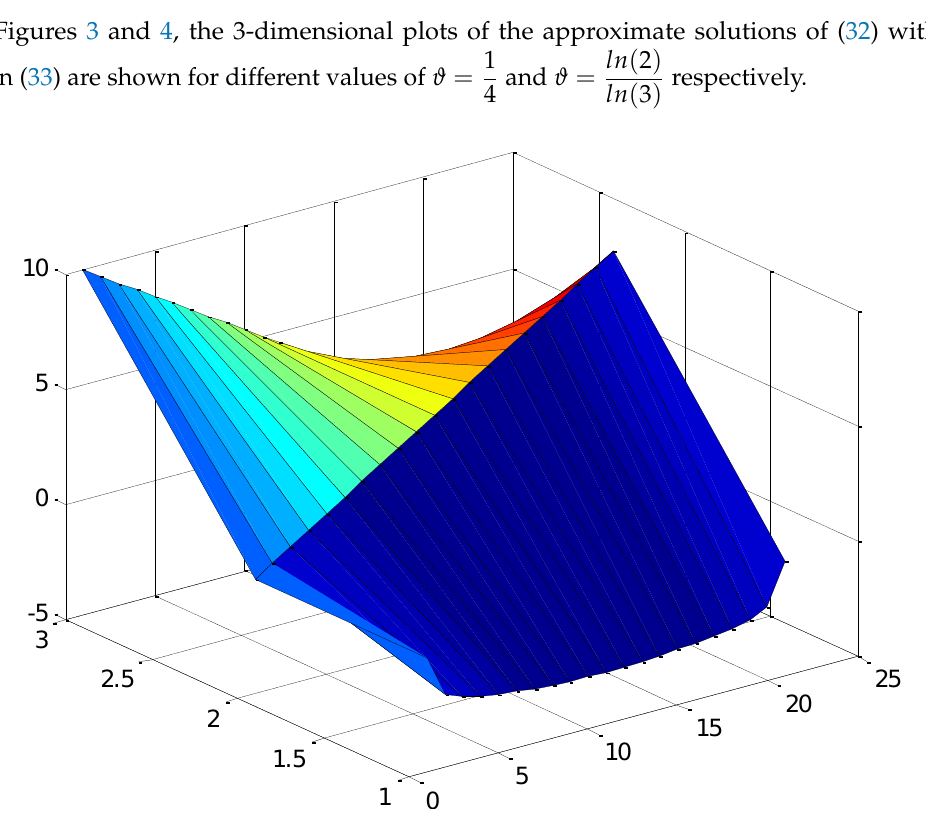
Figure 3. The plot of solution to dissipative wave equation with local fractional operators with fractal 1 dimension ϑ = Figure 3: The plot of solution to damped wave equation with local fractional operators with fractal dimension .